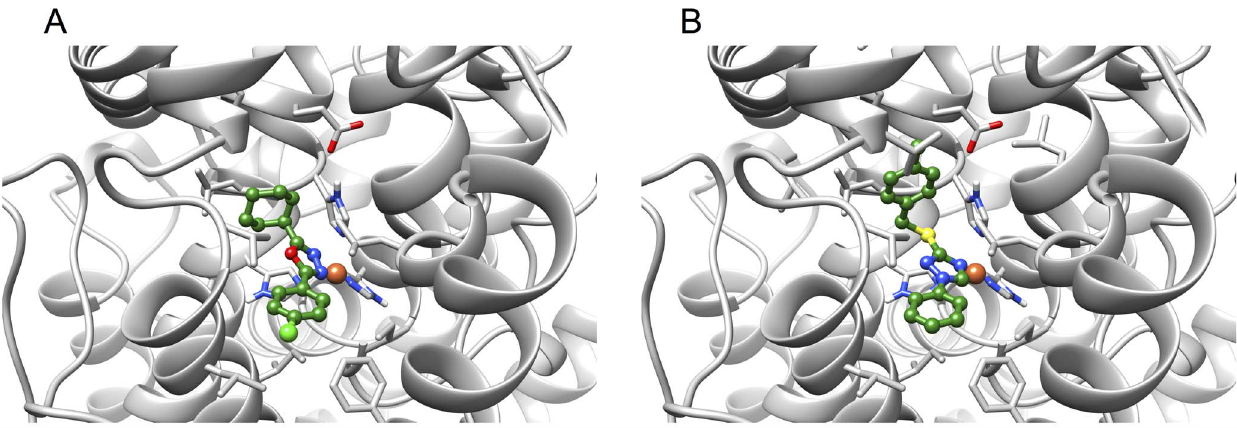
Figure 6. The docking poses of the ligands bound to 15-LOX-2 (A) MLS000545091 and (B) MLS000536924. Carbon atoms of the ligands are shown in green, while the carbon atoms of the protein are shown in grey. The oxygen, nitrogen and hydrogen atoms are shown in red, blue and white colors respectively. The metal ion (Fe 3 + ) is shown as an orange sphere. Residues that coordinate to the iron ion are also shown. All water molecules, including the ones that coordinate the metal ion, were deleted prior to docking.